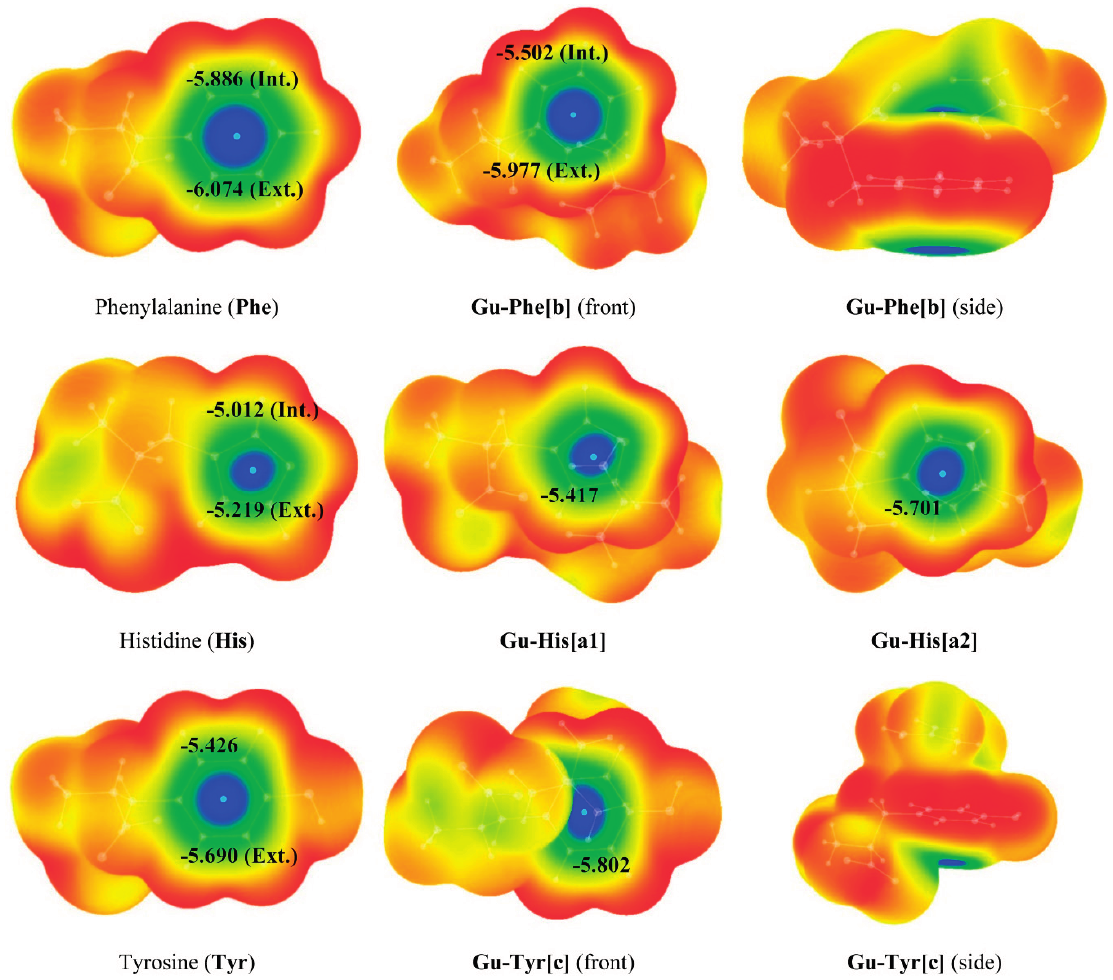
Figure 4. 3D-Representation of the NICS values (ppm) on the 0.001 a.u. electron density isosurfaces of Phe , His and Tyr and of the cation- π guanidinium complexes studied at M06-2X/6-311+G(d,p) computational level. Color code: blue < − 4.0, Green > − 4.0, Yellow > − 2.0, Red > 0.0. NICS minima values in the aromatic ring are marked with cyan